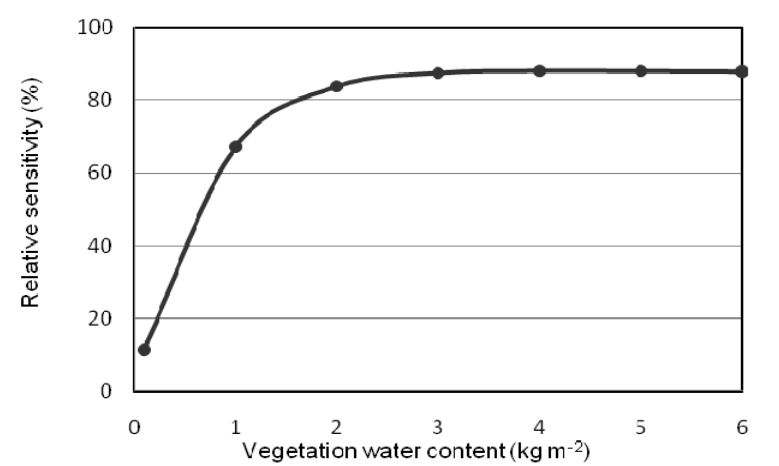
Figure 2. Relative sensitivity of b- factor with respect to vegetation water